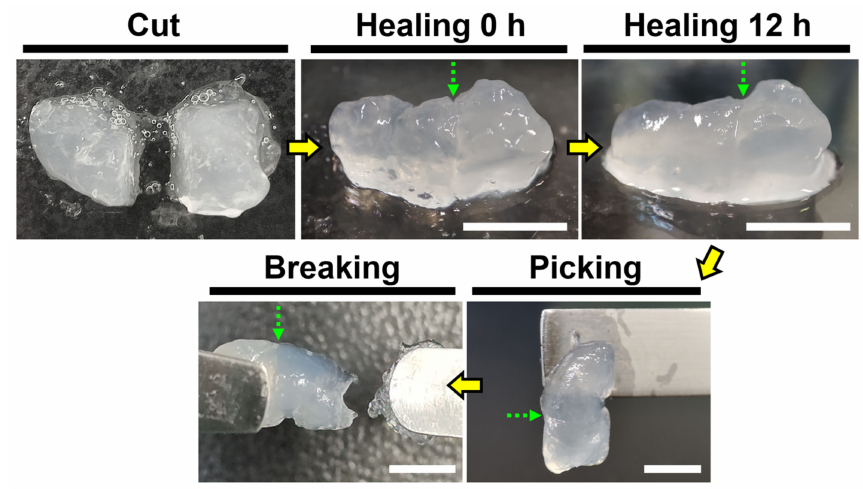
Figure 3. The self-healing behavior of the recombinant spider silk hydrogel, demonstrated by the gross test at 25 ◦ C. The green dotted arrows show the cut section of the hydrogel. Scale bars represent 5